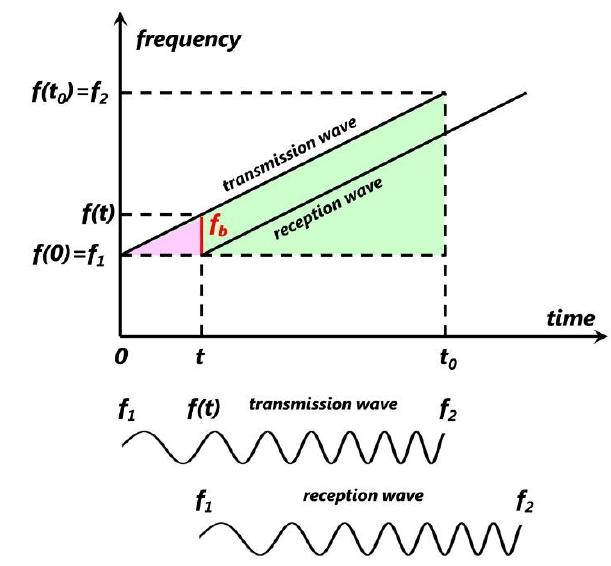
Figure 1. Outline of the R&D of drone-borne SAR system